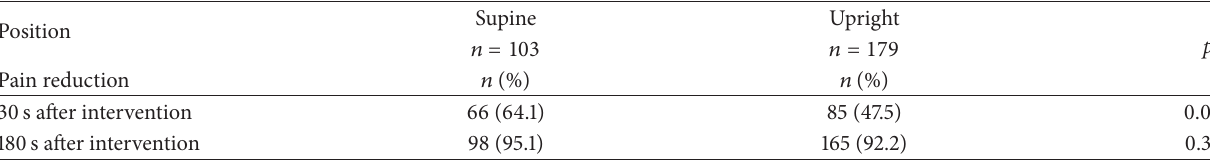
Table 5: Pain reduction after intervention by a composite